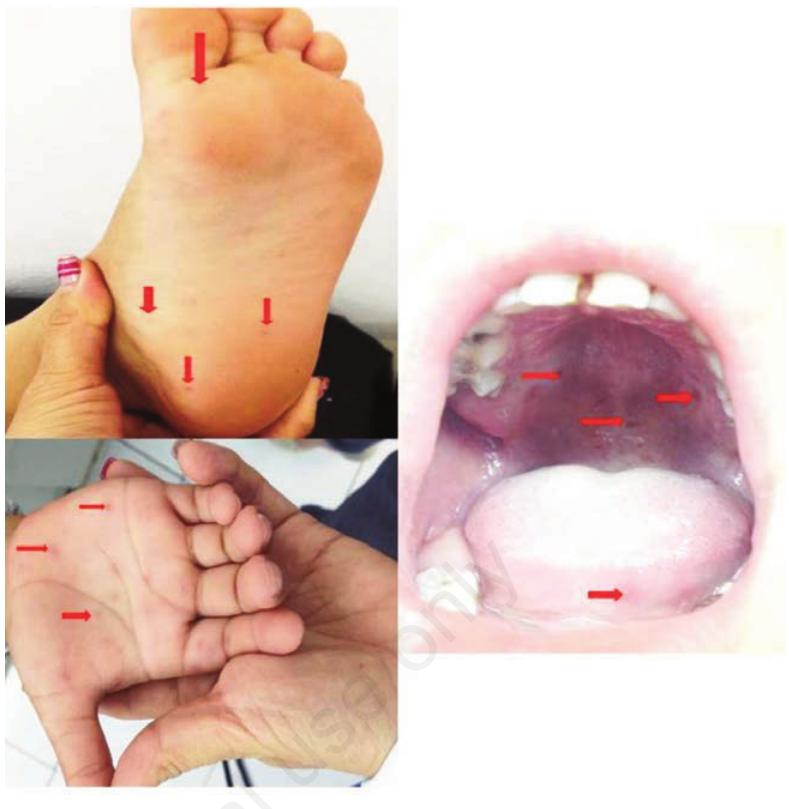
Figure 1. Lesions on the hands and soles of the feet, and blisters in the oral cavity of the patient who presented with hand, foot and mouth disease. Select lesions and blisters are indicated by red